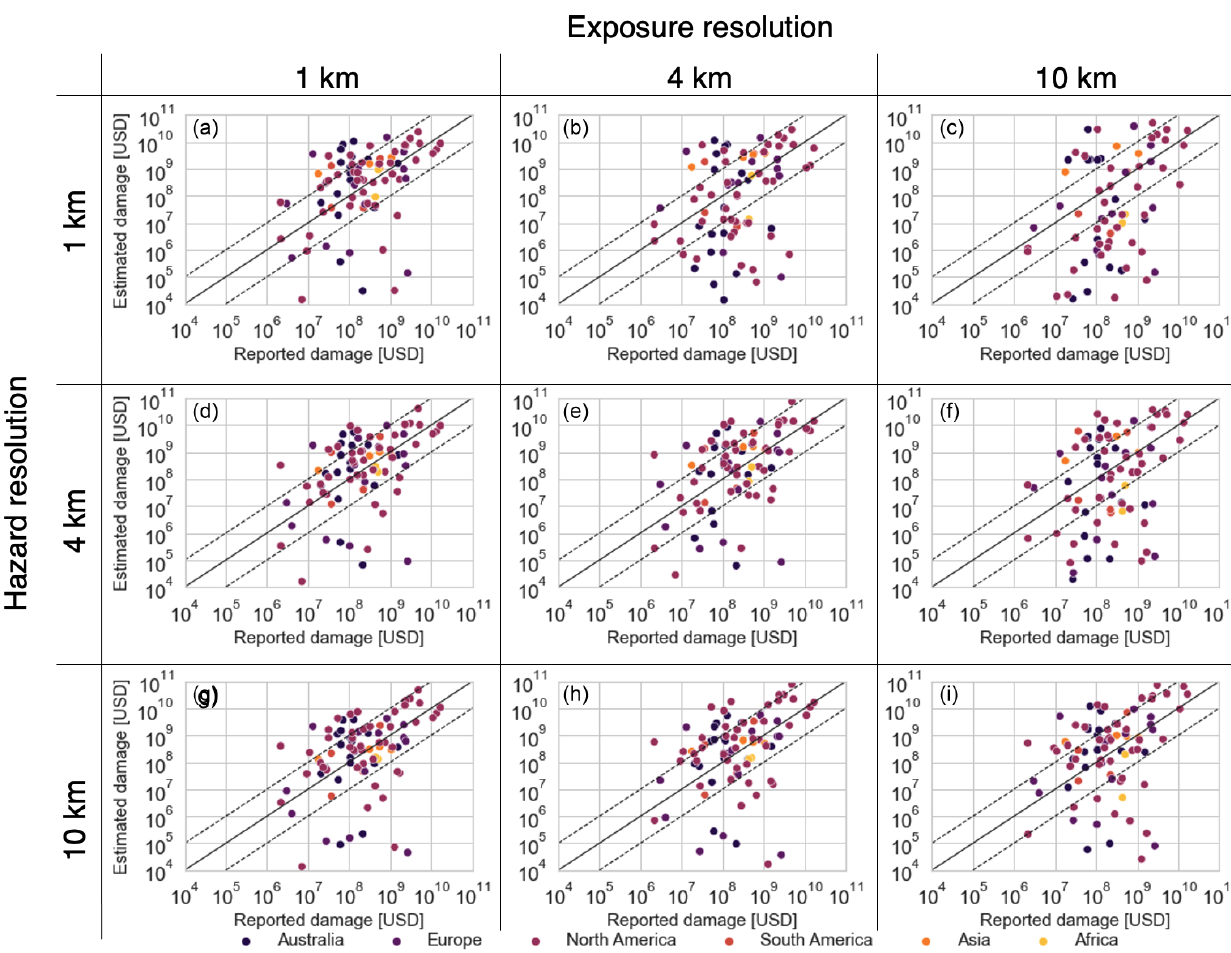
Figure A2. Reported damages against estimated damages, coloured per continent for different hazard and exposure resolutions. The dotted lines indicate deviations of an order of